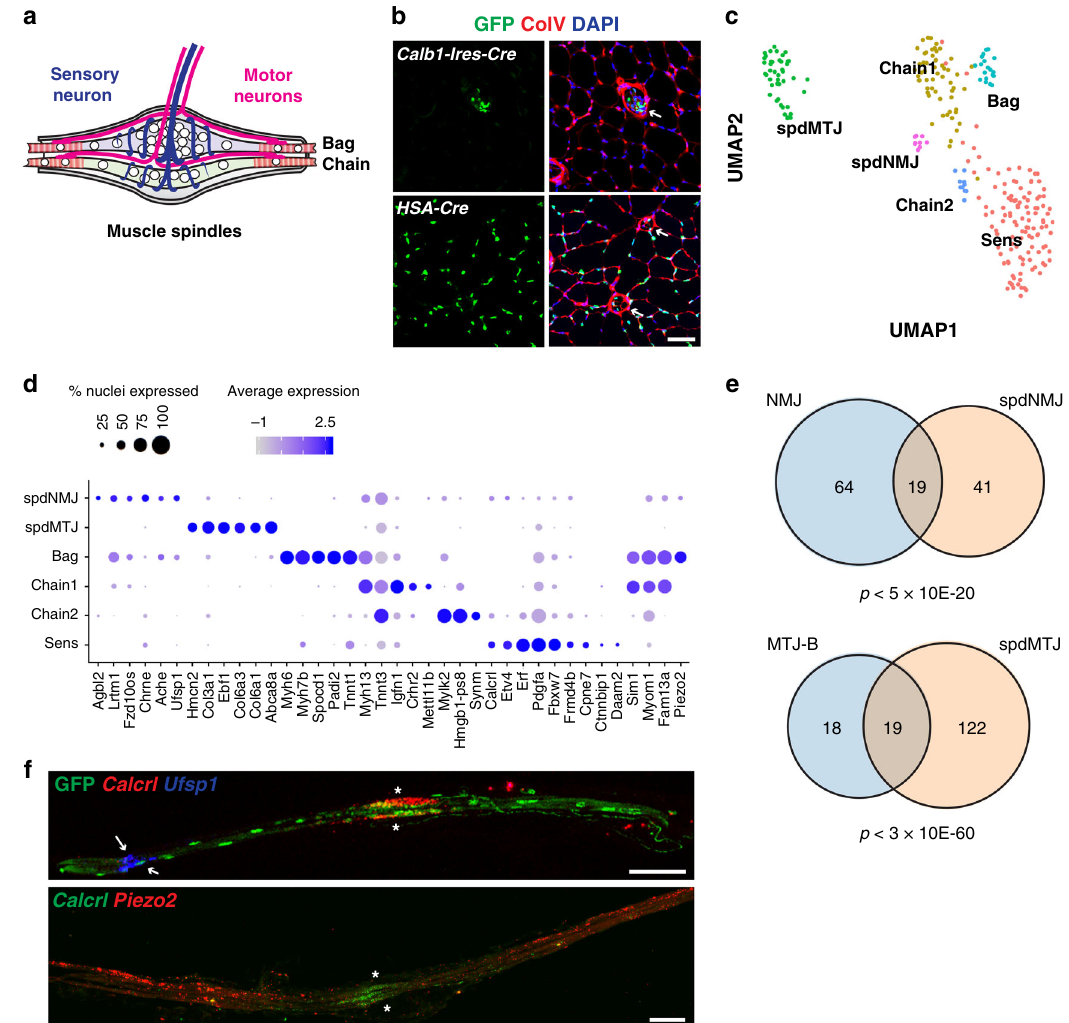
Fig. 5 Functional compartments inside muscle spindle fi bers. a Schema showing the structure of the muscle spindle. b Speci fi c labeling of spindle myonuclei using Calb1-Ires-Cre . Arrows indicate muscle spindles . c UMAP plot of muscle spindle myonuclei (260 nuclei). d Expression map of nuclear populations identi fi ed in ( c ). e Venn diagram comparing “ spdNMJ vs extrafusal fi ber NMJ ” and “ spdMTJ vs extrafusal fi ber MTJ-B ” . Genes enriched in each population (average logFC > 0.7) were used to generate the diagrams. Statistical analysis was performed using hypergeometric test using all genes detected in uninjured/regenerating and spindle datasets as background. f Single-molecule FISH experiments of isolated muscle spindle fi bers. Arrows indicate spdNMJ, and asterisks the central non-contractile parts of spindle fi bers. All scale bars, 50 µ m. Expression patterns were validated in two or more